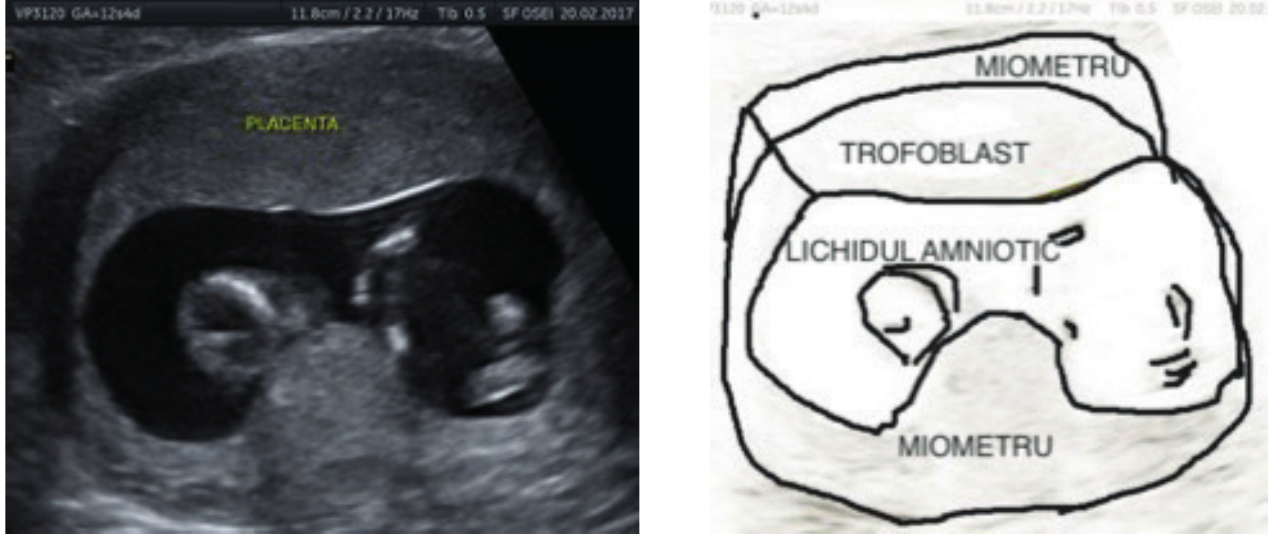
Figure 1 - Transabdominal ultrasound showing the anterior placenta in the first trimester of pregnancy exhibiting the following ultrasonographic signs of normal placenta : inserted in the fundus of uterus, thick retroplacentar myometrium, placenta homogenious, no placental lacunae, no